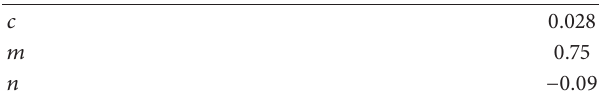
Table 2: Empirical constants